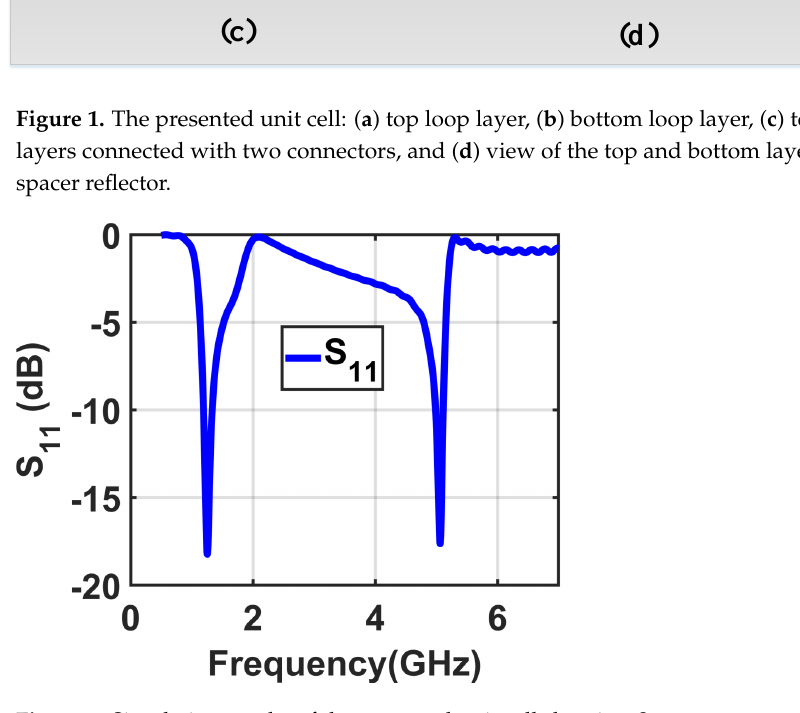
Figure 2. Simulation results of the proposed unit cell showing S 11